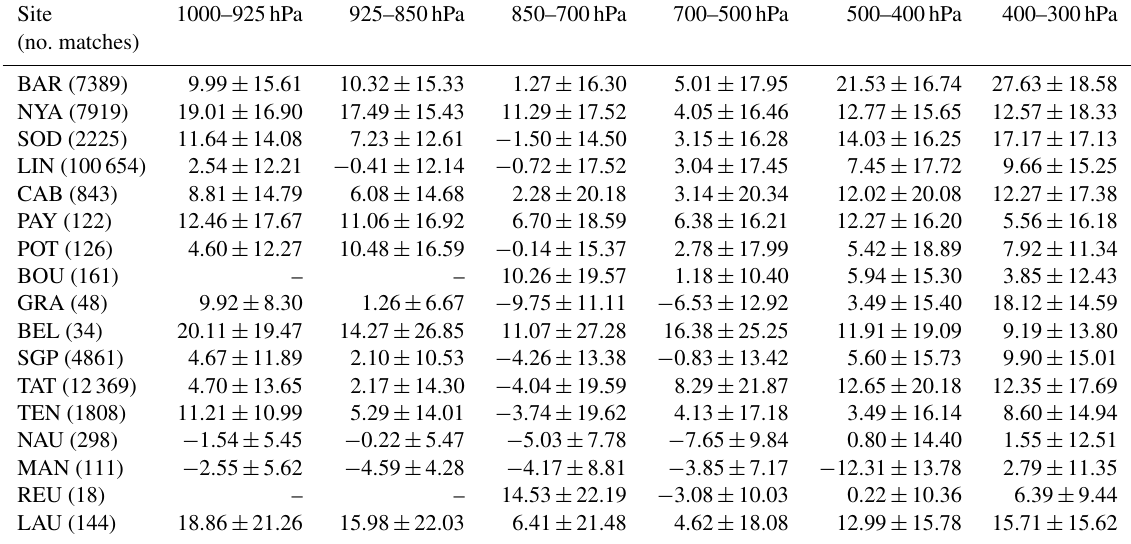
Table 1. Breakdown of GRUAN site-specific IMS water vapour profile biases and standard errors (given in %ppmv) for the same layers shown in Fig. 6. The site short names correspond to the details given in Table A1 and are accompanied by the total number of matches made with IMS. Sites appear in latitudinal order (north to south). After quality filtering, ≈ 90% of all matches remain at all